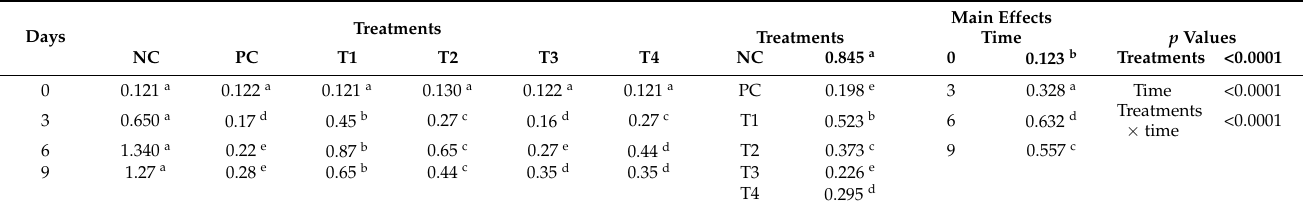
Table 4. Changes in thiobarbituric acid reactive substances values of minced pork depending on treatment and storage